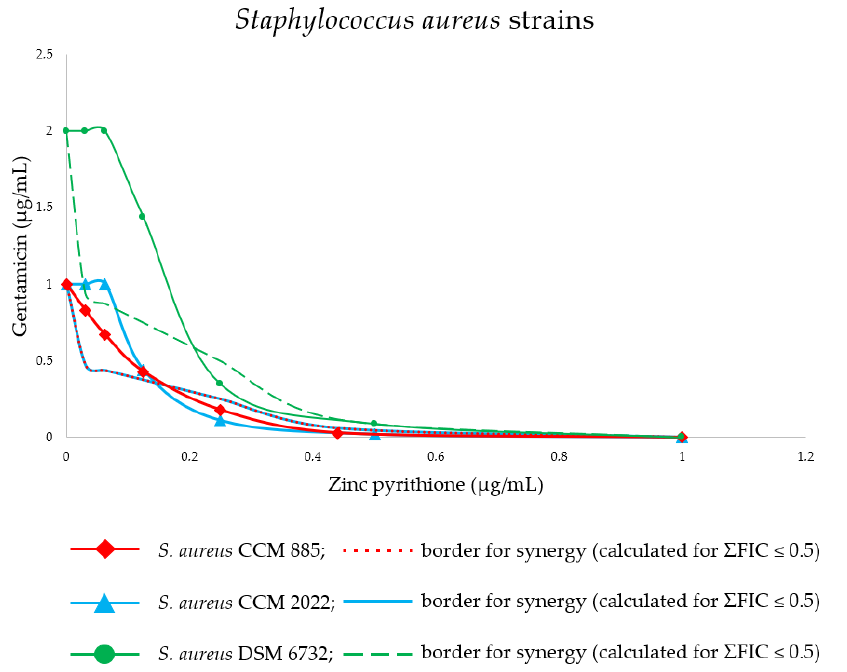
Figure 2. Isobologram of the interactions between gentamicin and zinc pyrithione binary combina- tions against Staphylococcus aureus strains. Synergy (ΣFIC ≤ 0.5).